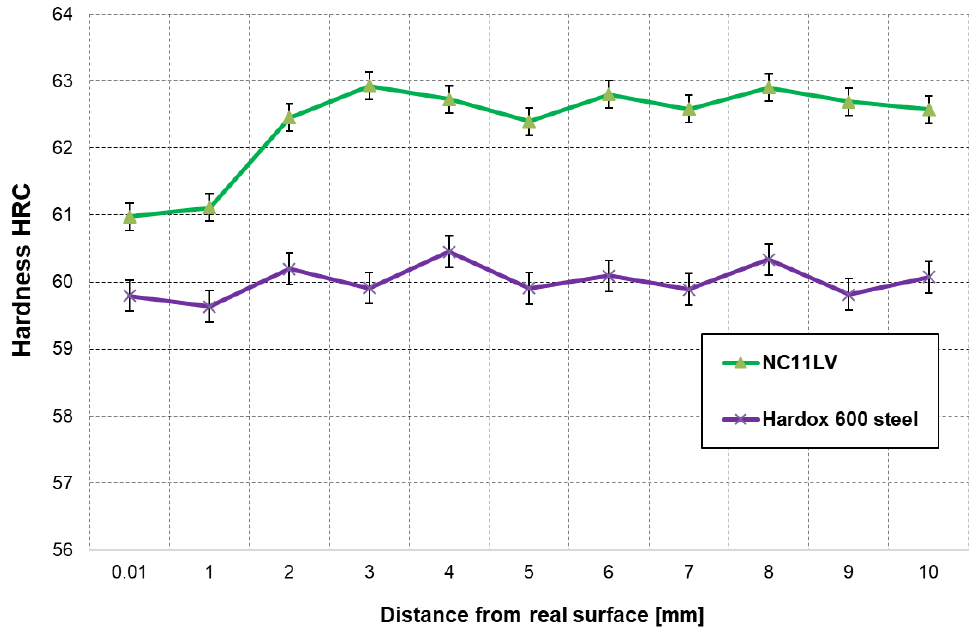
Figure 6. Hardness profiles at a distance from the working surface for tool samples made of steel NC11LV and Hardox 600.